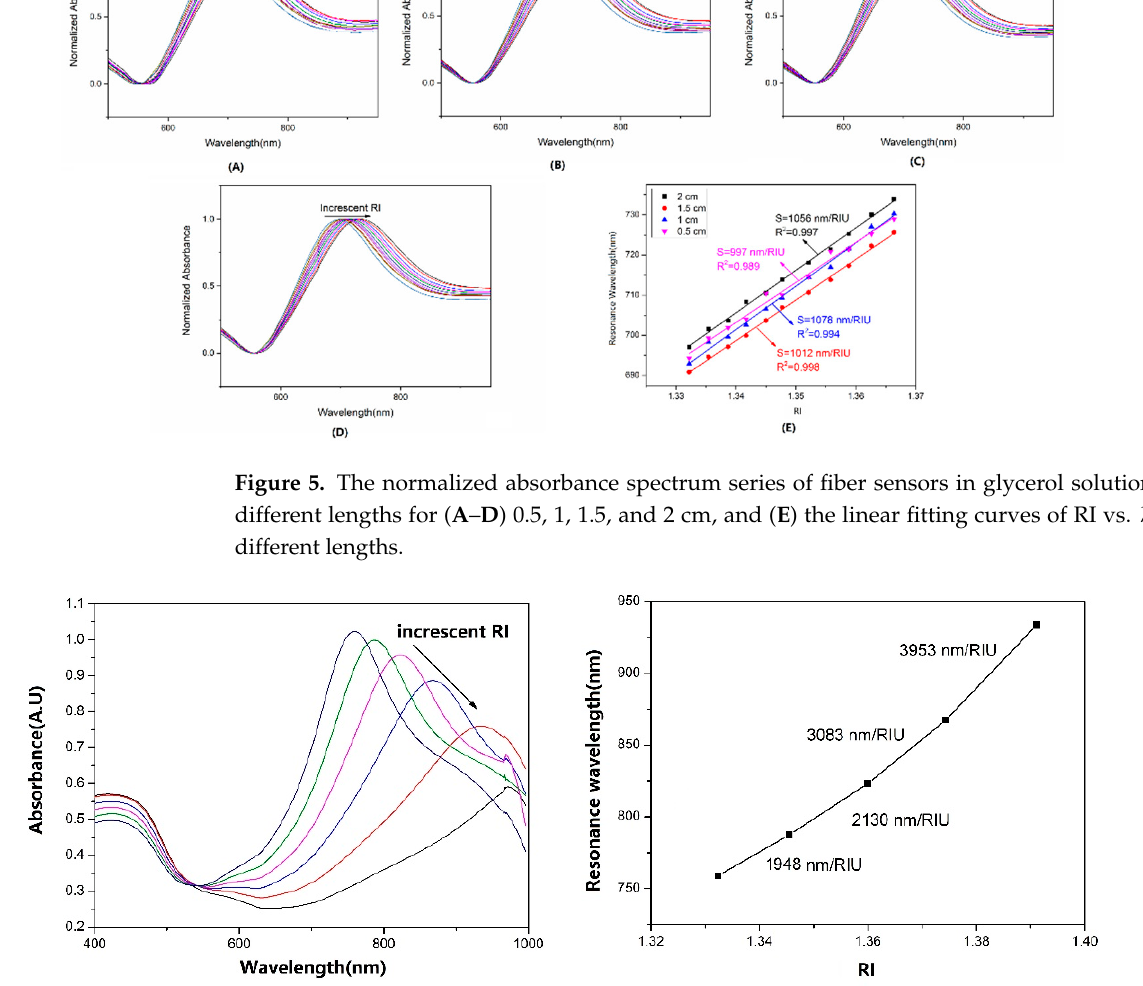
Figure 5. The normalized absorbance spectrum series of fiber sensors in glycerol solutions with different lengths for ( A – D ) 0.5, 1, 1.5, and 2 cm, and ( E ) the linear fitting curves of RI vs. λ p with different lengths.